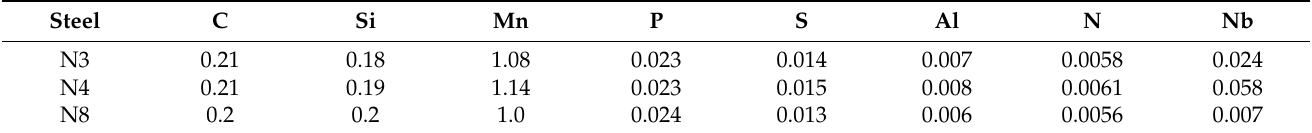
Figure 1. Variation in the recrystallized fraction ( X a ) with time ( t ), Reprinted from Ref. [14]. Table 1. Chemical composition of steels used for model modification in wt.%.